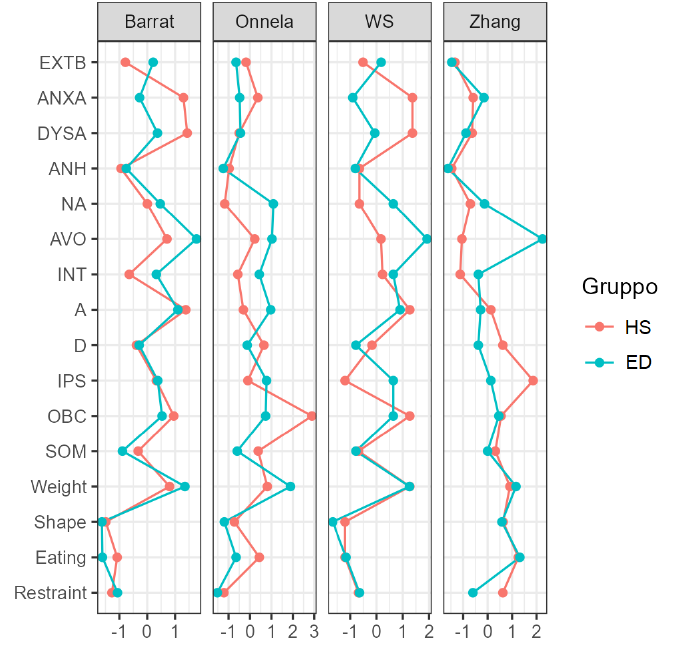
Figure 3. Plot of the clustering indices of the networks. Extb: externalizing behavior, anxa: anxious arousal, dysa: dysphoric arousal, anh: anhedonia, na: negative affect, avo: avoidance, int: intrusion, a: anxiety, d: depression, ips: interpersonal sensitivity, obc: obsessive-compulsive, som: